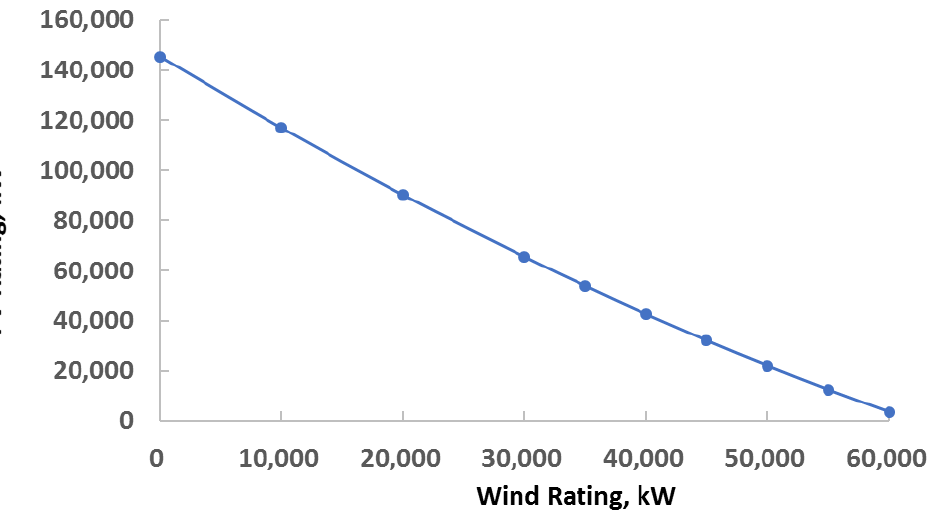
Figure 5. The combination of wind and solar installation power ratings to supply both electricity and heat.